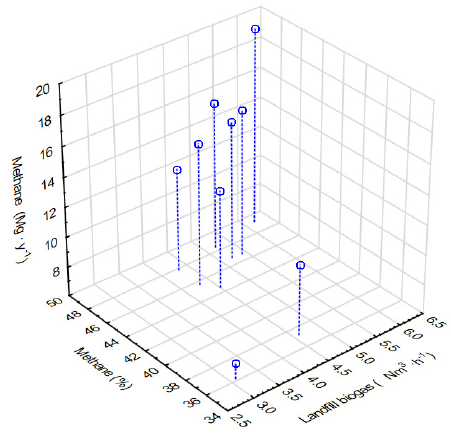
Figure 5. Capacity of the degassing installation.